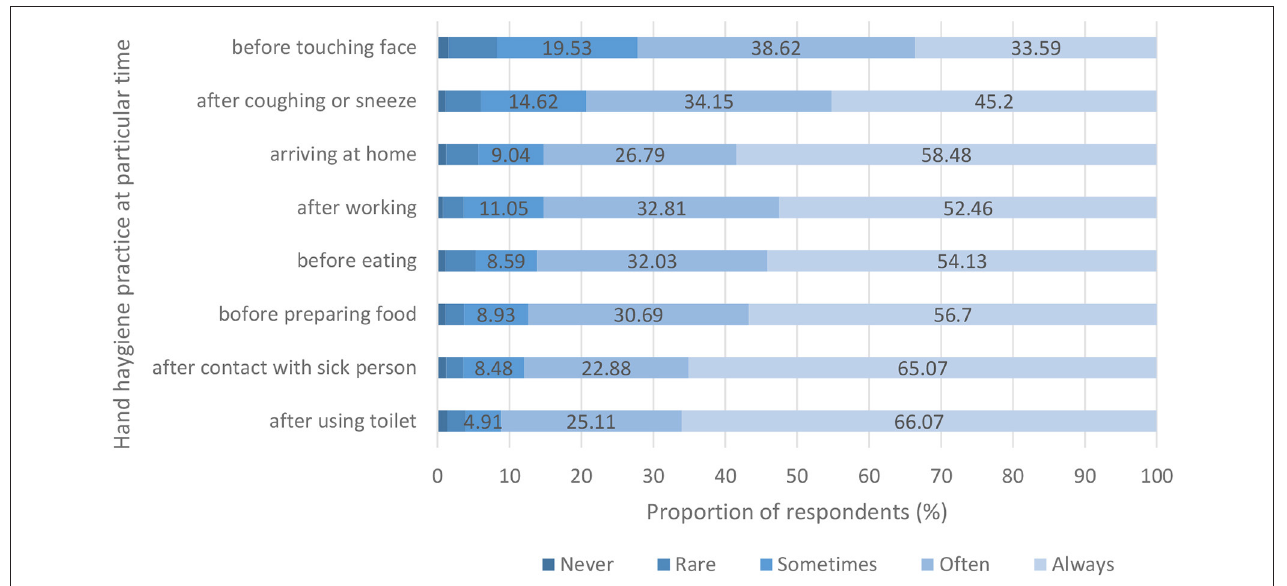
FIGURE 3 | Respondents reporting hand hygiene practice at particular time with five different categories of frequencies.